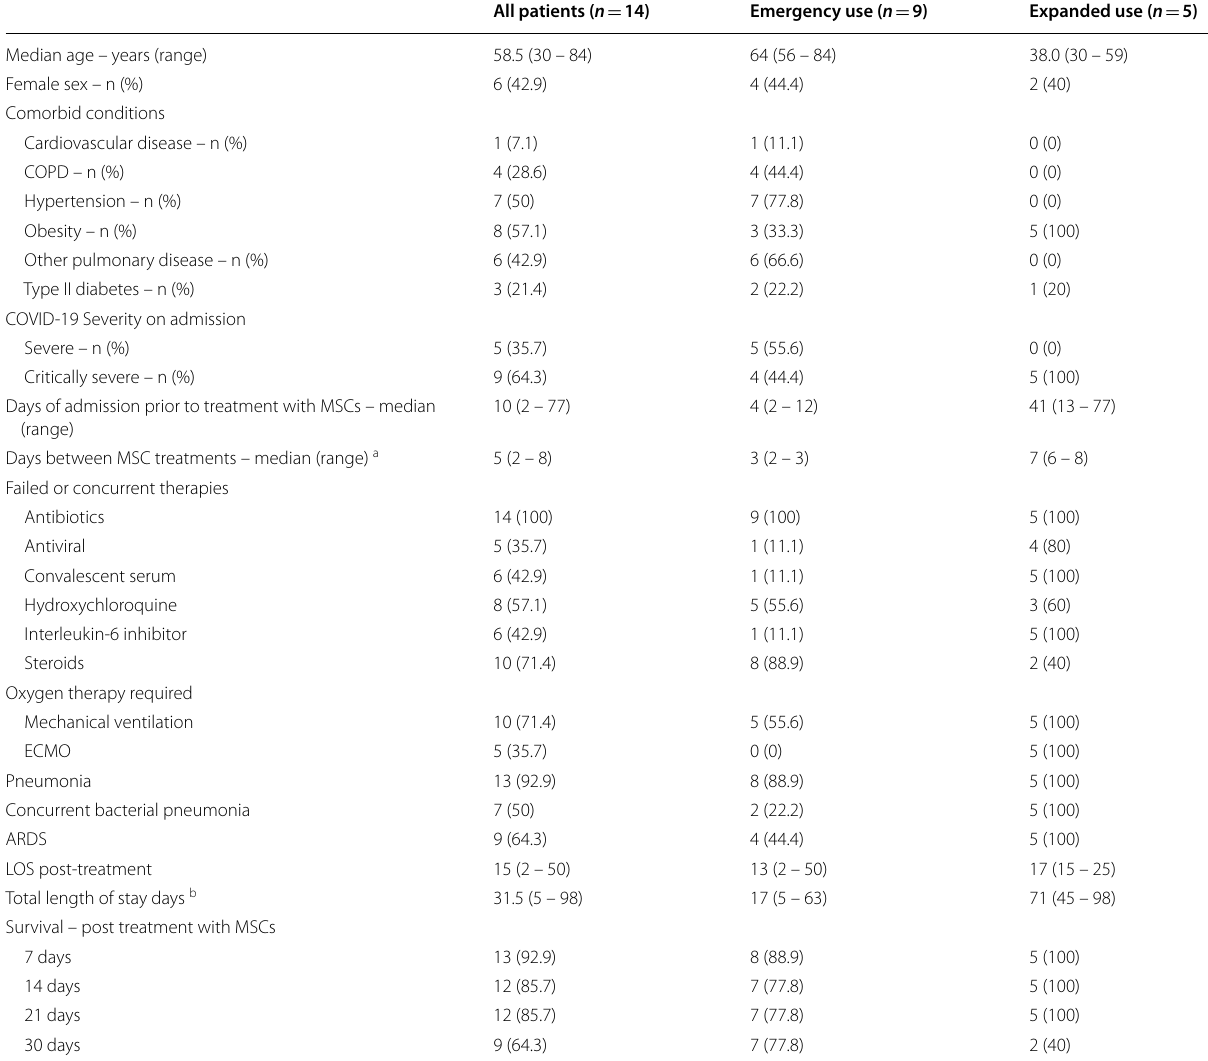
Table 1 Baseline, treatment, and outcome characteristics of patients treated with Mesenchymal Stem Cells (MSCs) under emergency use and expanded use